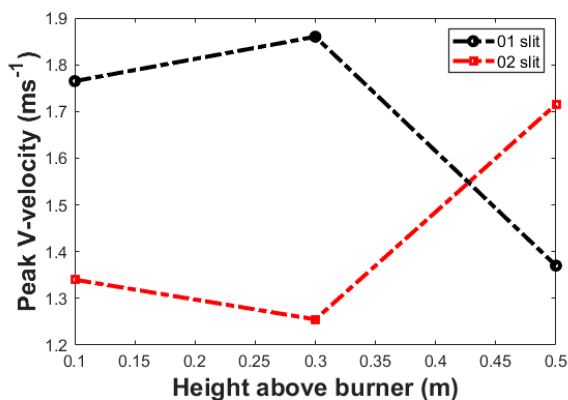
Figure 10. Peak value of V-velocity of the two cases, at all monitoring HABs.